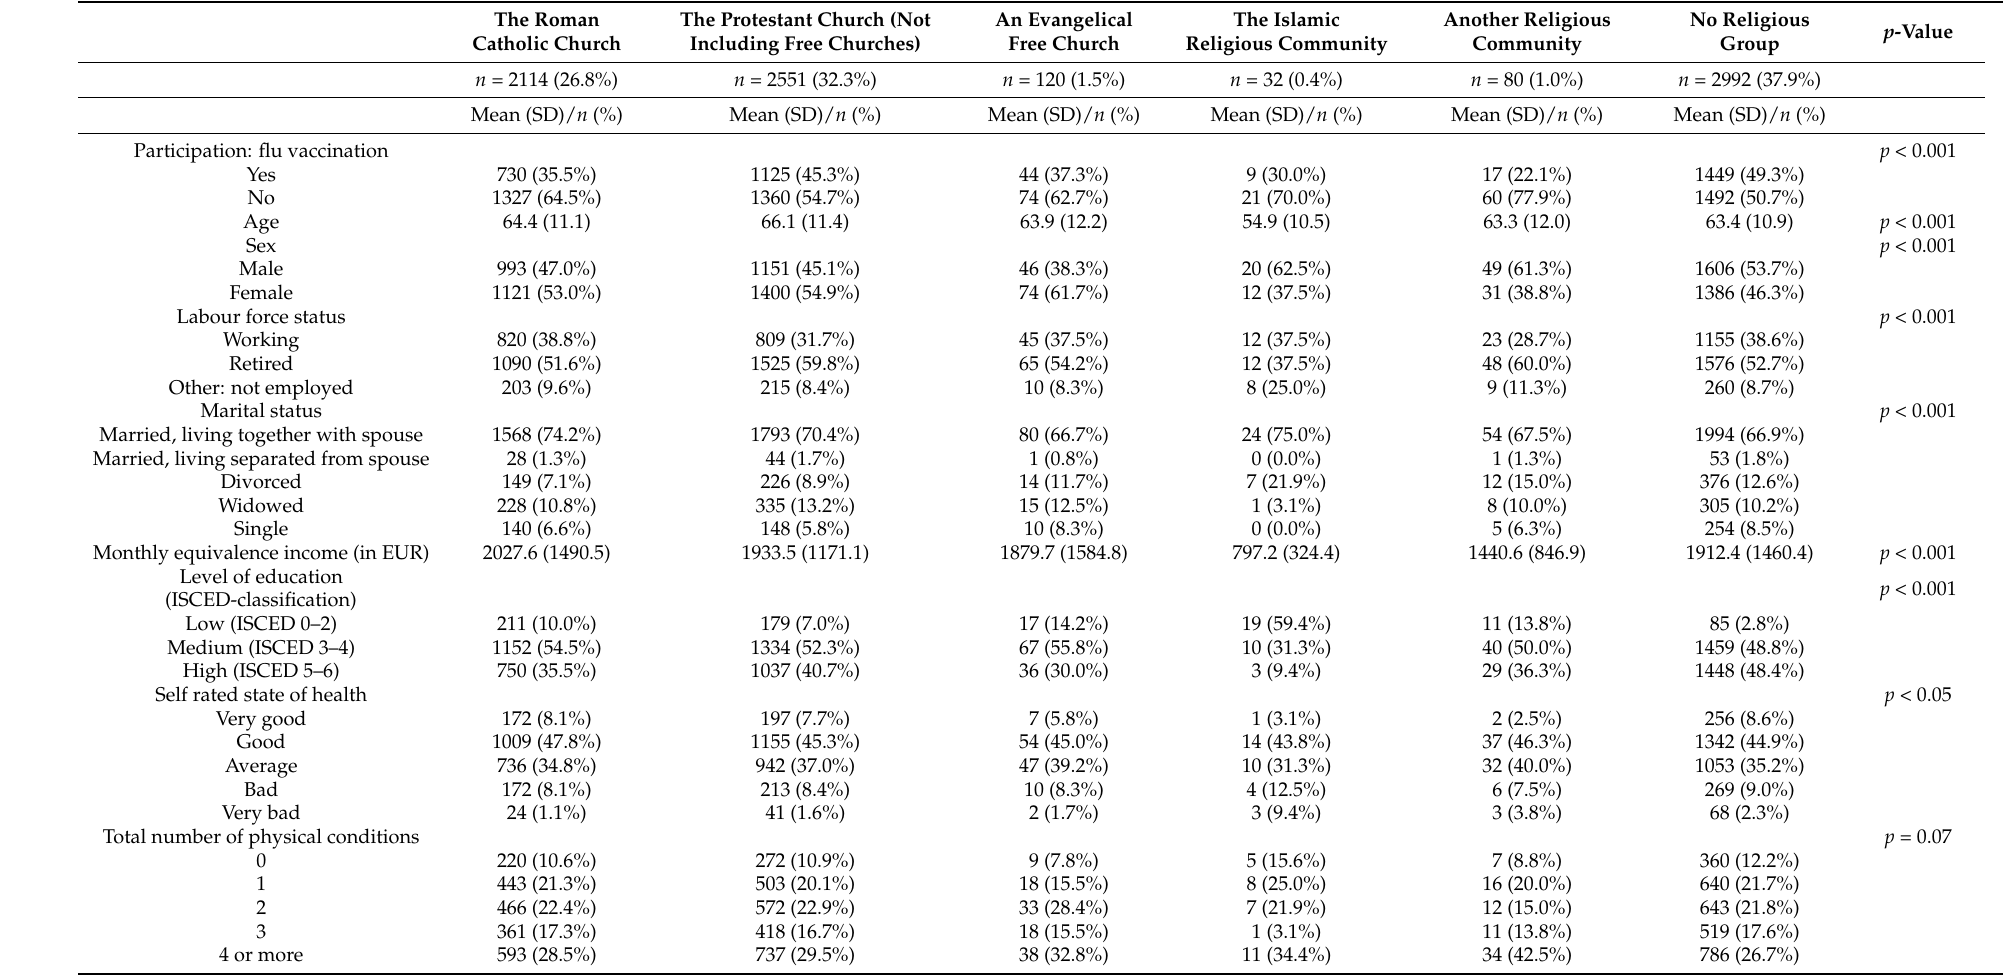
Table 1. Sample characteristics (stratified by religious